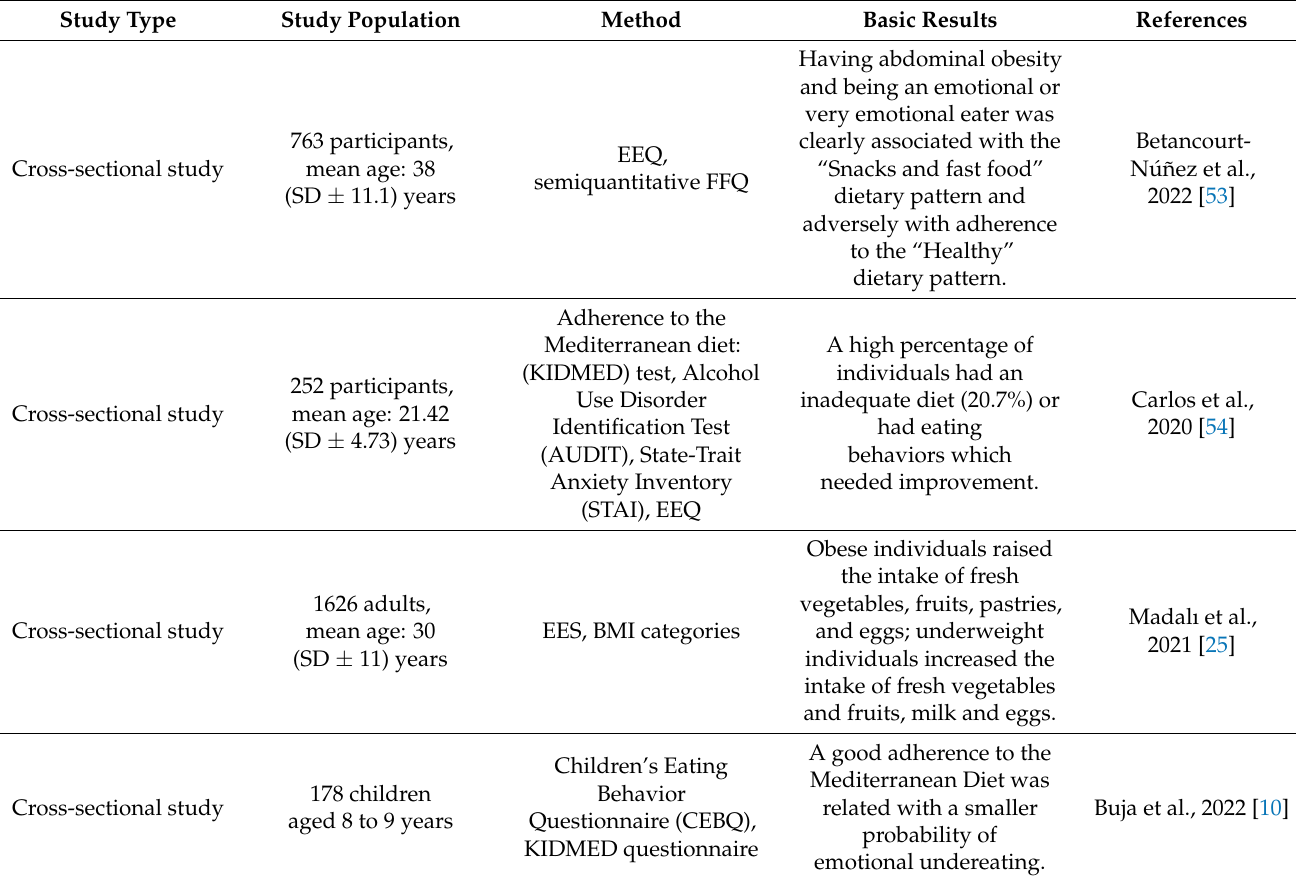
Table 4. Clinical studies evaluating the association of emotional eating with dietary